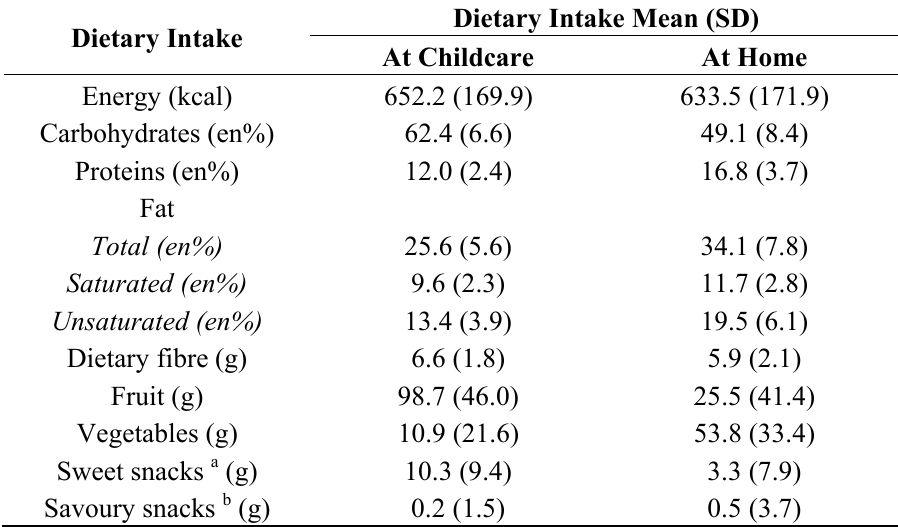
Table 2. Dietary intake by toddlers at childcare and at home ( N =